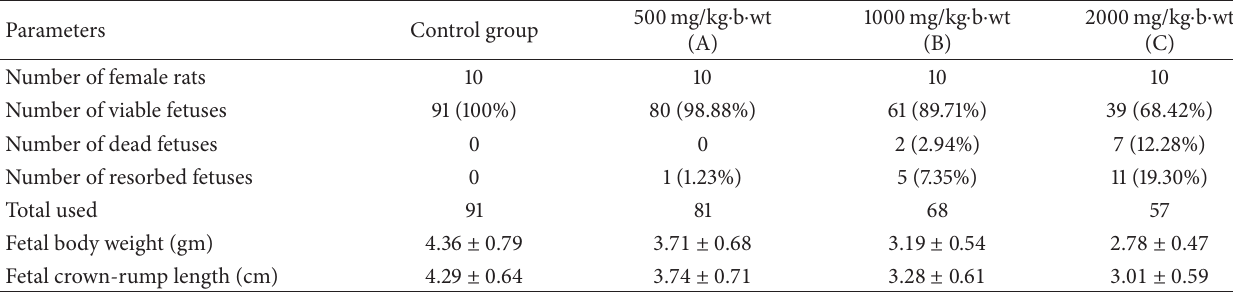
Table 1: Effect of norfloxacin on fetuses obtained from pregnant female rats after repeated oral administration of 500, 1000, and 2000 mg